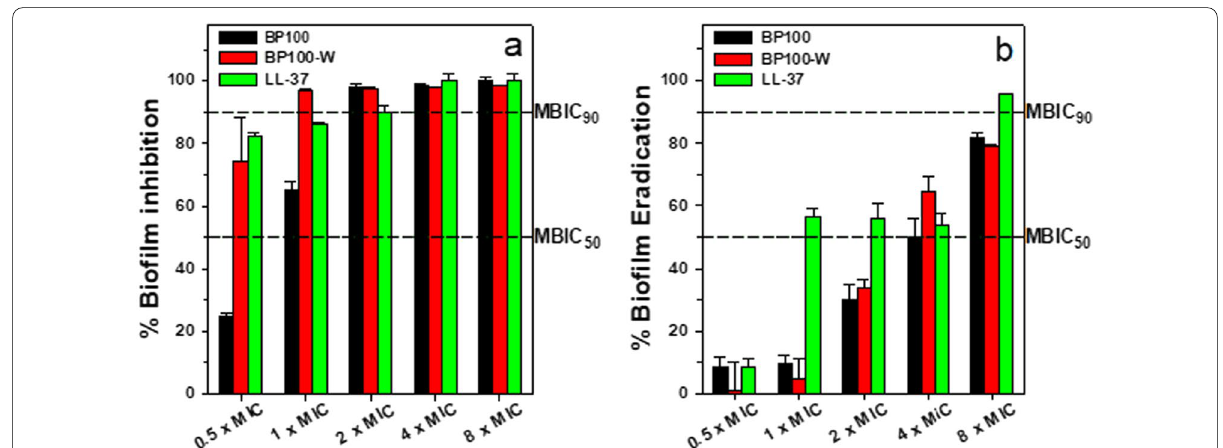
Fig. 4 In vitro antibiofilm activities of BP100, BP100-W and LL-37 against multidrug-resistant Pseudomonas aeruginosa (MDRPA). a Biofilm inhibition. b Biofilm eradication. Dashed lines indicate 50 and 90% inhibition and eradication concentration